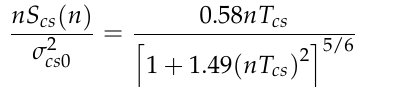
/ σ 2 as a function of ∆ T / T CS compared with analytic CS CS 0